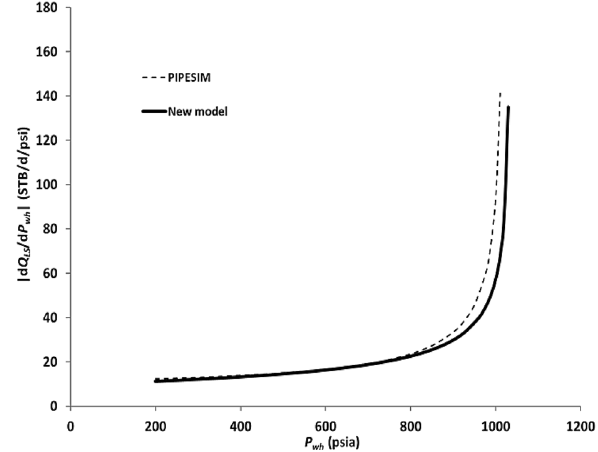
Fig. 9 Stability plots for well